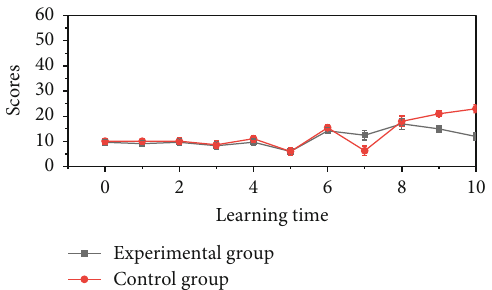
Figure 7: Di ffi culty map under fl ipped classroom teaching.